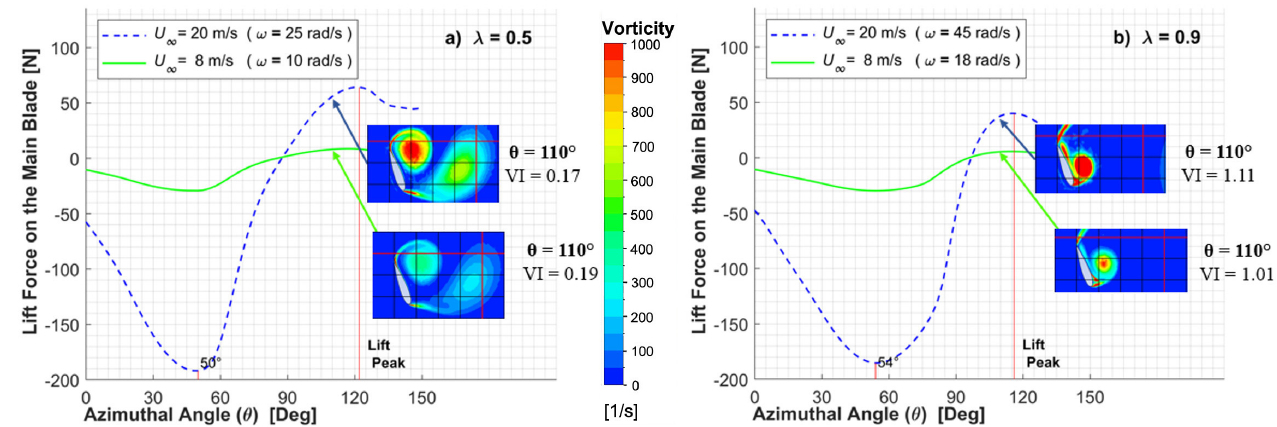
Figure 20. Drag Force and VI for Blade 1 with Azimuthal Position for U ∞ = 8 m/s and U ∞ = 20 m/s at: ( a ) λ = 0.5 and ( b ) λ = 0.9, Using the 2D Model of the Present Study.